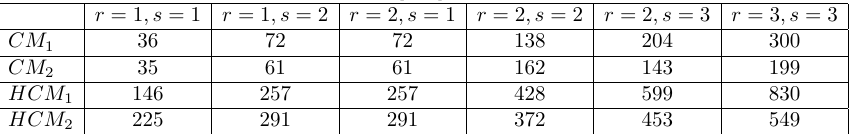
Table 2. first and second reverse Zagreb and first and second reverse Hyper Zagreb indices for Si 2 C 3 II [ r, s ] for spefic values of r and